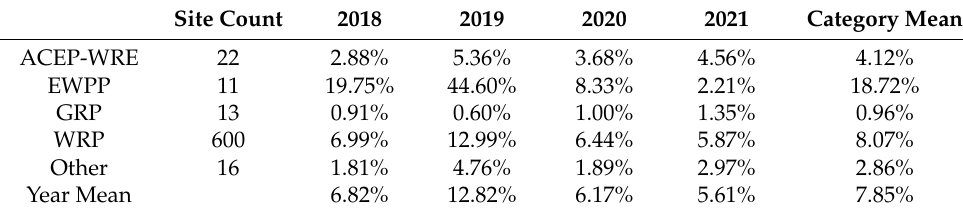
Table 2. The percentage of inundated areas in each category of CE sites during